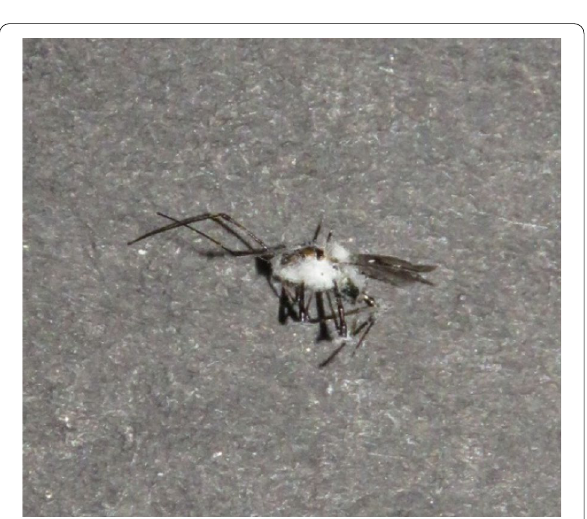
Fig. 8 Well-grown Lecanicillium longisporum on adult